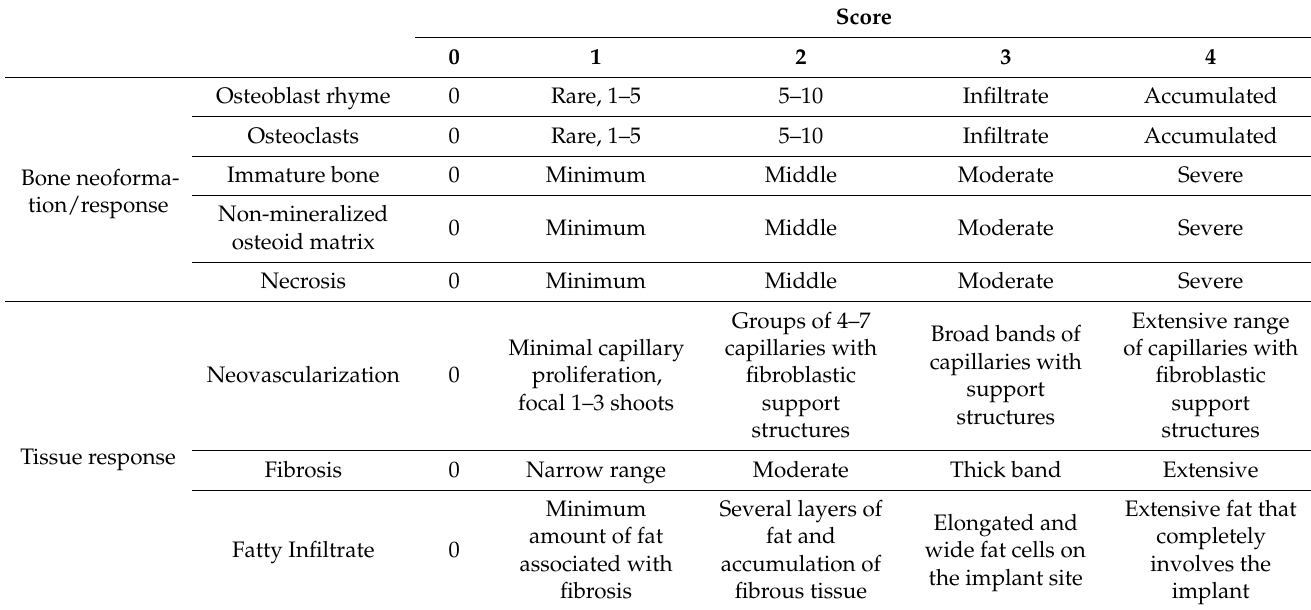
Table 1. Histological parameters and criteria to score and evaluate bone neoformation and reaction (per field, 400 × , and a mean of five fields) and tissue